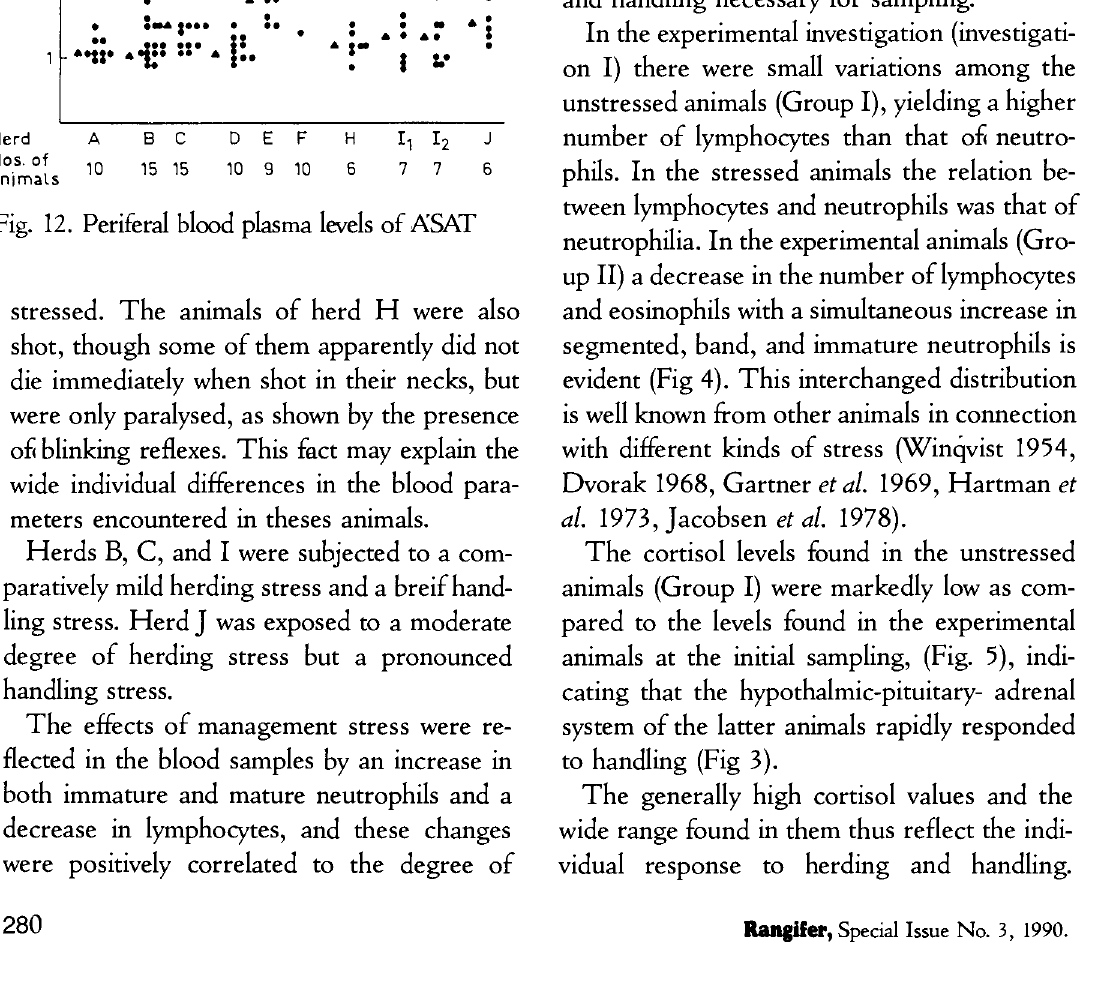
Fig. 12. Periferal blood plasma levels of ASAT stressed. The animals of herd H were also shot, though some of them apparently did not die immediately when shot in their necks, but were only paralysed, as shown by the presence of blinking reflexes. This fact may explain the wide individual differences in the blood para meters encountered in theses